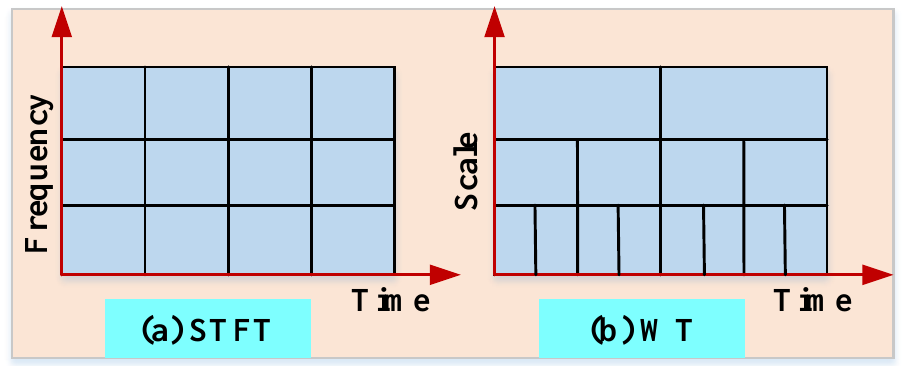
Figure 15. Resolution of AE signal after transforming based on ( a ) STFT and ( b ) WT